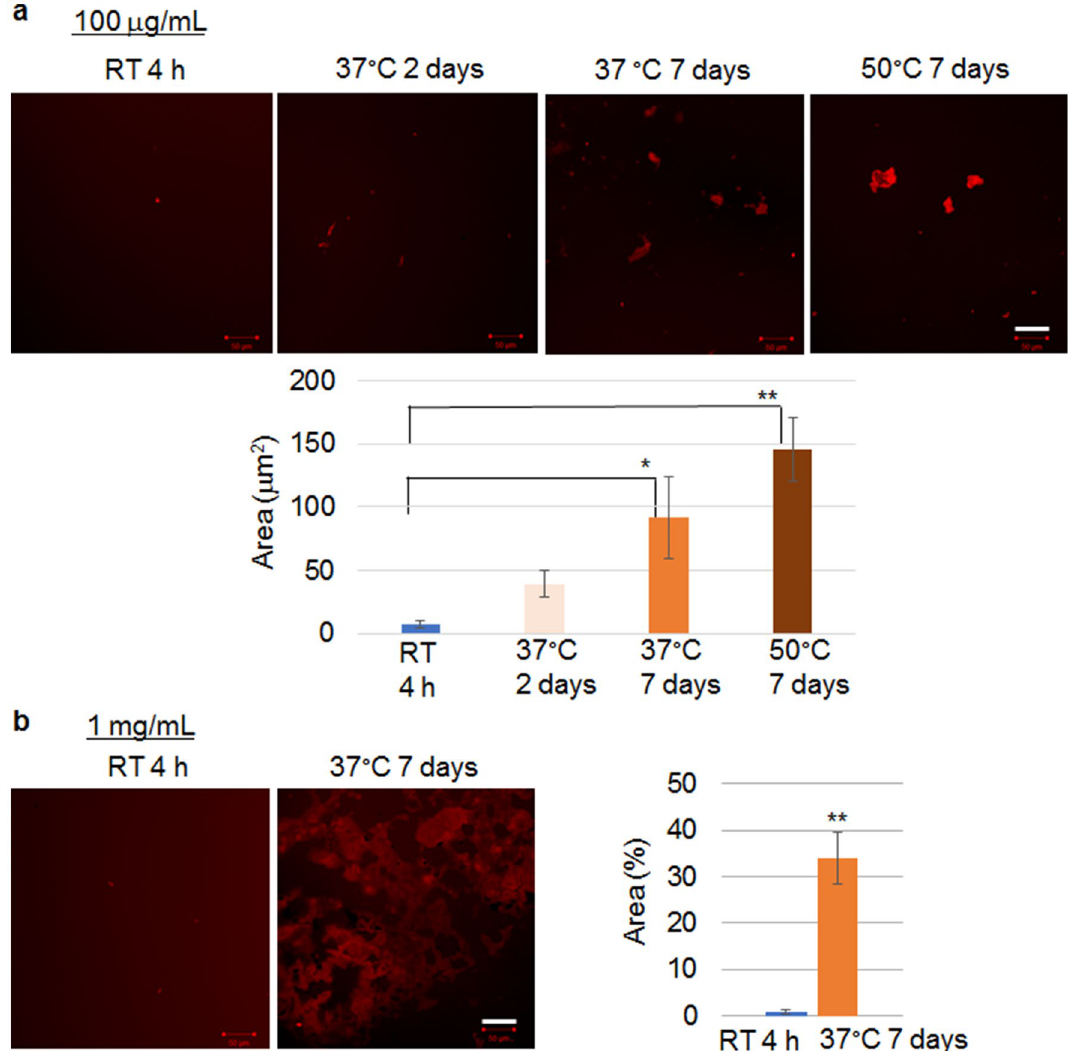
Figure 2. Comparison of the aggregation of peptides with 13 alanine repeats under multiple concentrations, temperatures, and incubation times. ( a ) Quantification of the area of aggregate clusters of TAMRA-labeled 13A peptide (100 µg/mL, red) incubated for 4 h at room temperature (RT) (n = 15 from 7 images), for 2 d at 37 °C (n = 15 from 9 images), for 7 d at 37 °C (n = 14 from 7 images), or for 7 d at 50 °C (n = 16 from 6 images) (bottom). Representative confocal images are shown (top). ANOVA followed by posthoc test, *p < 0.05, **p < 0.01. ( b ) TAMRA-labeled 13A peptide (1 mg/mL, red) incubated for 4 h at RT or for 7 d at 37 °C. Representative confocal images are shown (left). Quantification of the percentage of the area occupied by aggregates in a field of view (n = 5 each) (right). Each error bar represents the SE. Student’s t-test, **p < 0.01. Scale bars, 50